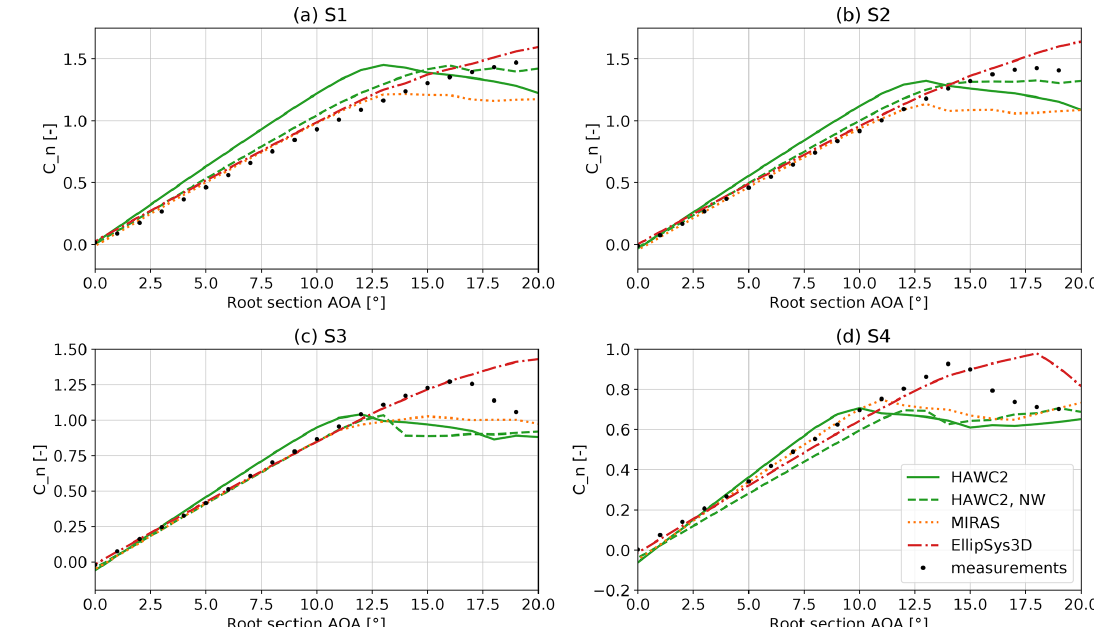
Figure 14. Comparison of measured and simulated c n at the four instrumented sections for clean airfoils.